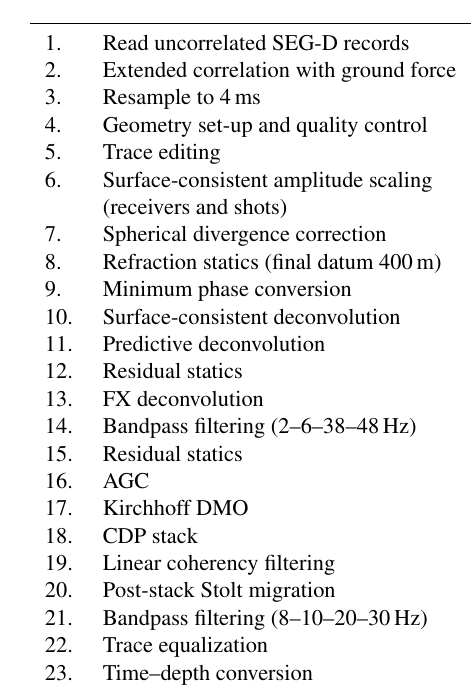
Table 1. Data processing